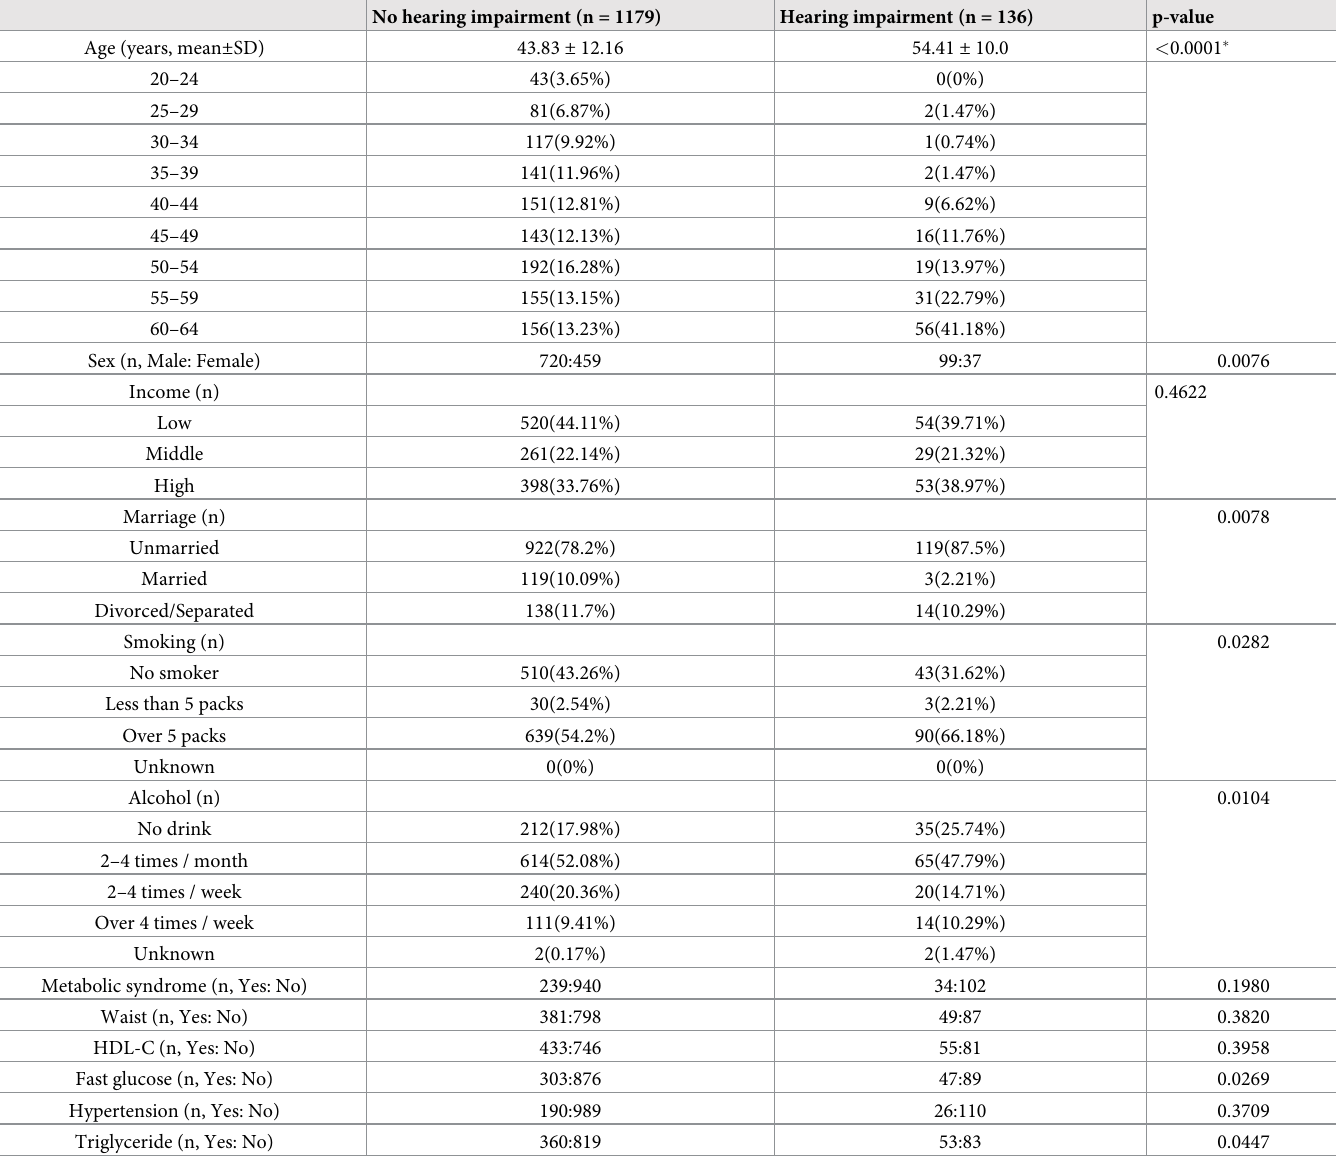
Table 2. Comparisons of demographic and clinical characteristics between subjects with and without hearing impairment in noise-exposed